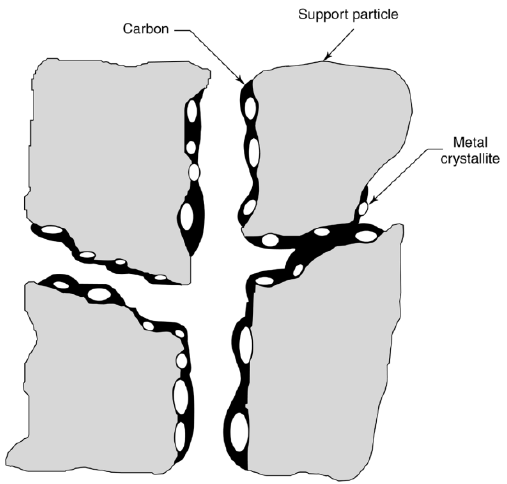
Figure 10. Conceptual model of fouling, crystallite encapsulation, and pore plugging of a supported metal catalyst owing to carbon deposition. Reproduced from [8]. Copyright 2006,